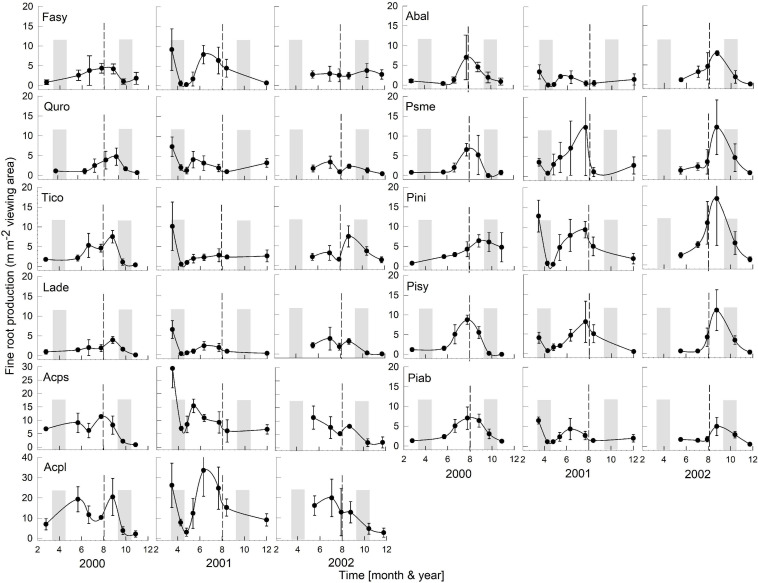
Seasonality of monthly averaged fine-root length production ( ± SE) of 11 temperate tree species growing in a common garden for the years 2000–2002. Species are abbreviated with the first two letters of their genus and species name. Gray bars indicate observed bud break and leaf flush (mid-March to mid-May) as well as leaf fall (mid-September to end of October) of each year. The dashed line is the center of the observed growing season (June–October). Each plot was weighted equally in calculating the seasonal patterns (3–6 plots per species; see section “Materials and Methods” for details). Root production data in this figure were adjusted to 28 day intervals to account for uneven image recording dates within a year. The first data point in each year assumed that root growth did not occur in December or January (see section “Materials and Methods”). Note, the y-axis range for all species is 0–20, except for Acps it is 0–30 and Acpl it is 0–40.